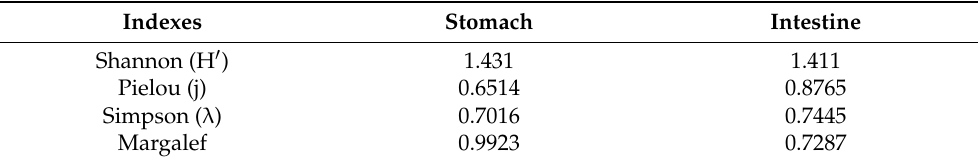
Table 2. Diversity by means of Shannon (H (cid:48) ), Pielou (j), Simpson ( λ ), and Margalef indexes of parasites from D. eleginoides captured in waters of the south-central zone of Chile.